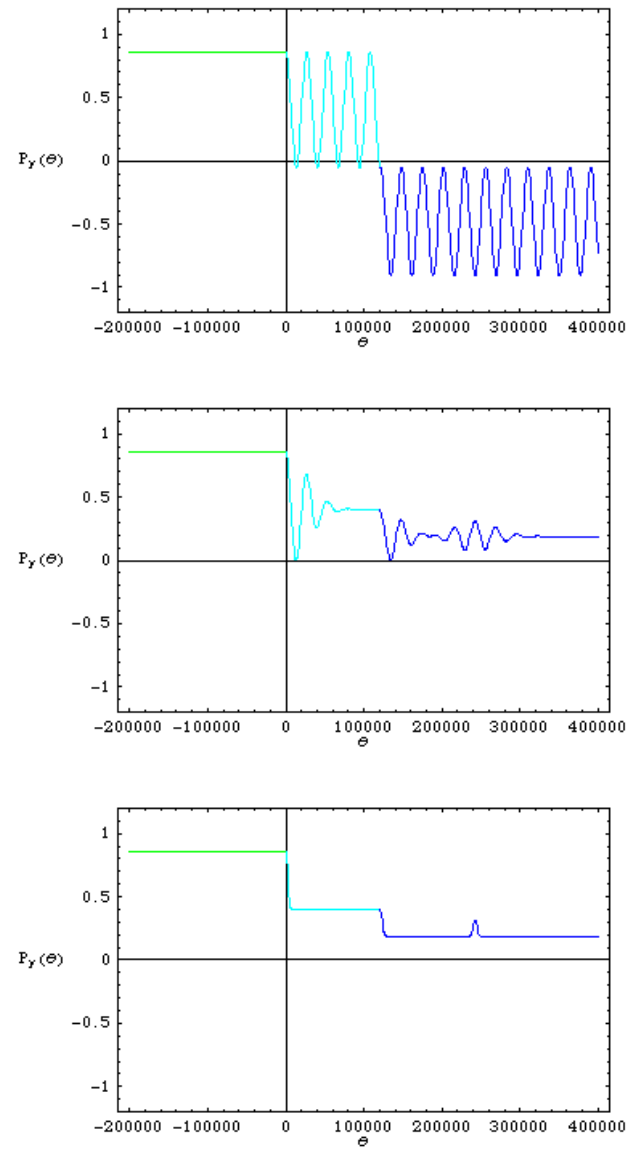
FIG. 5. (Color) Conditions are the same as in Fig. 3, except that (cid:1) 0 (upper), this is for a beam with finite energy spread; (cid:10) (cid:11) (cid:1) 10 (cid:3) 5 (middle), (cid:10) (cid:1) 10 (cid:3) 4 (lower). As (cid:10) (cid:10) increases, the (cid:11) (cid:11) (cid:11) interference-overlap effect is suppressed while an echo signal becomes more apparent. We have taken (cid:4) (cid:1) 4 : 4